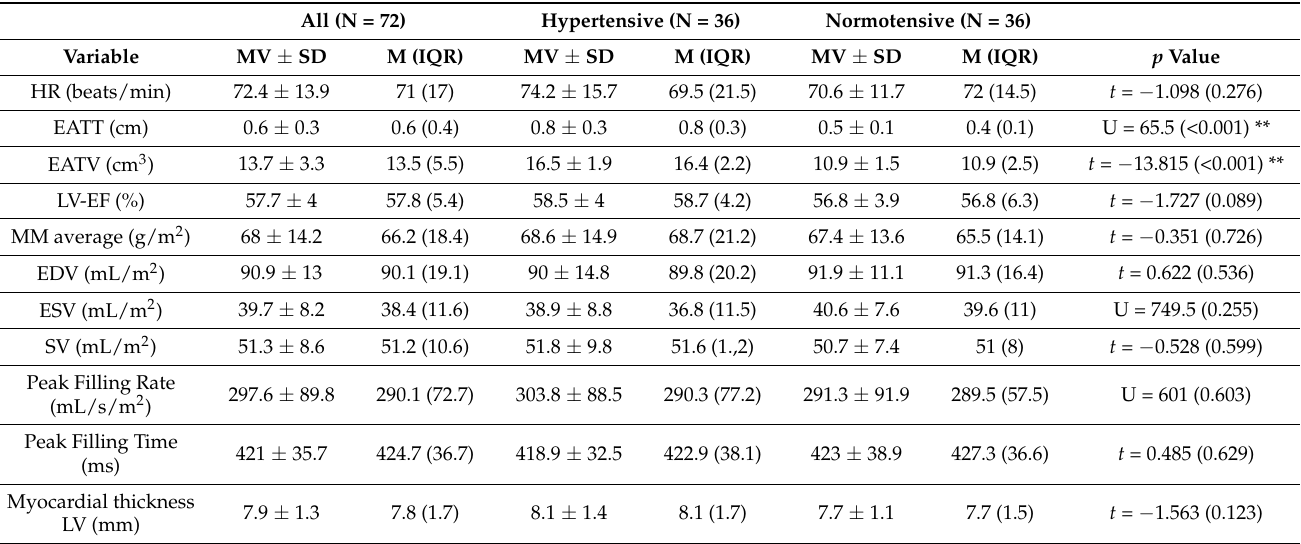
Table 2. Parameters of cardiac morphology and function.